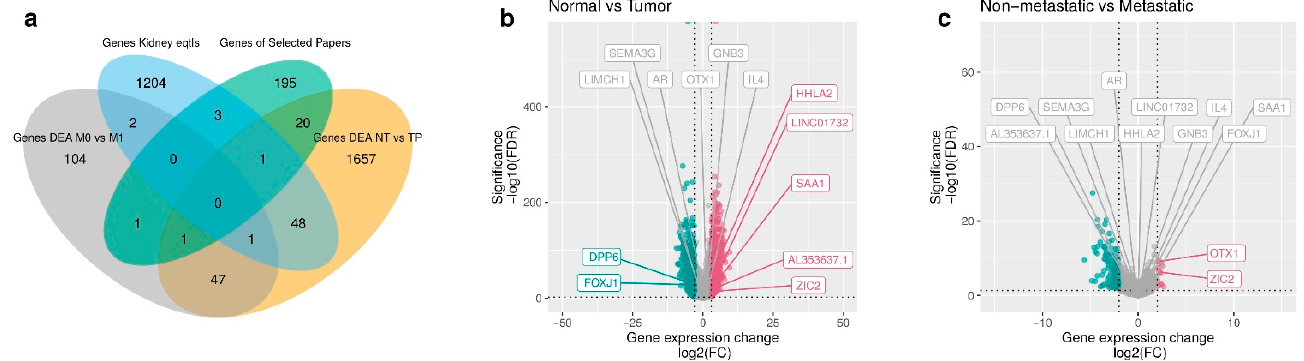
Figure 2. Selected genes through mRMR. ( a ) Venn diagram of prefiltered gene sets. A total of 3284 prefiltered genes is given by the sets of DEA between non-metastatic versus metastatic (156), normal tissues versus primary tumor (1775), genes from literature (221), significant eQTLs genes (1259), and 124 genes overlapping in two or three intersections of sets. ( b ) Volcano plot of DEA comparing normal tissues versus primary tumor samples of TCGA-KIRC. In green, we see the downregulated genes of normal tissues versus primary tumors (DPP6 and FOXJ1). In red, we see the upregulated genes (HHLA2, LINC01732, SAA1, AL353637.1, and ZIC2). In gray, we see the non significant genes with low fold change. ( c ) Volcano plot of DEA comparing non-metastatic versus metastatic samples. In red, we see the upregulated genes (OTX1 and